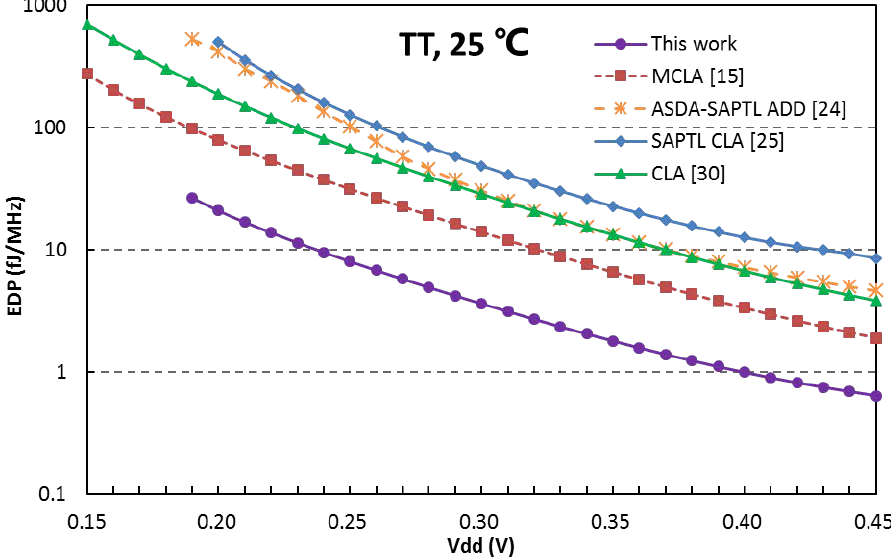
Figure 10. The energy-delay production (EDP) versus V dd .